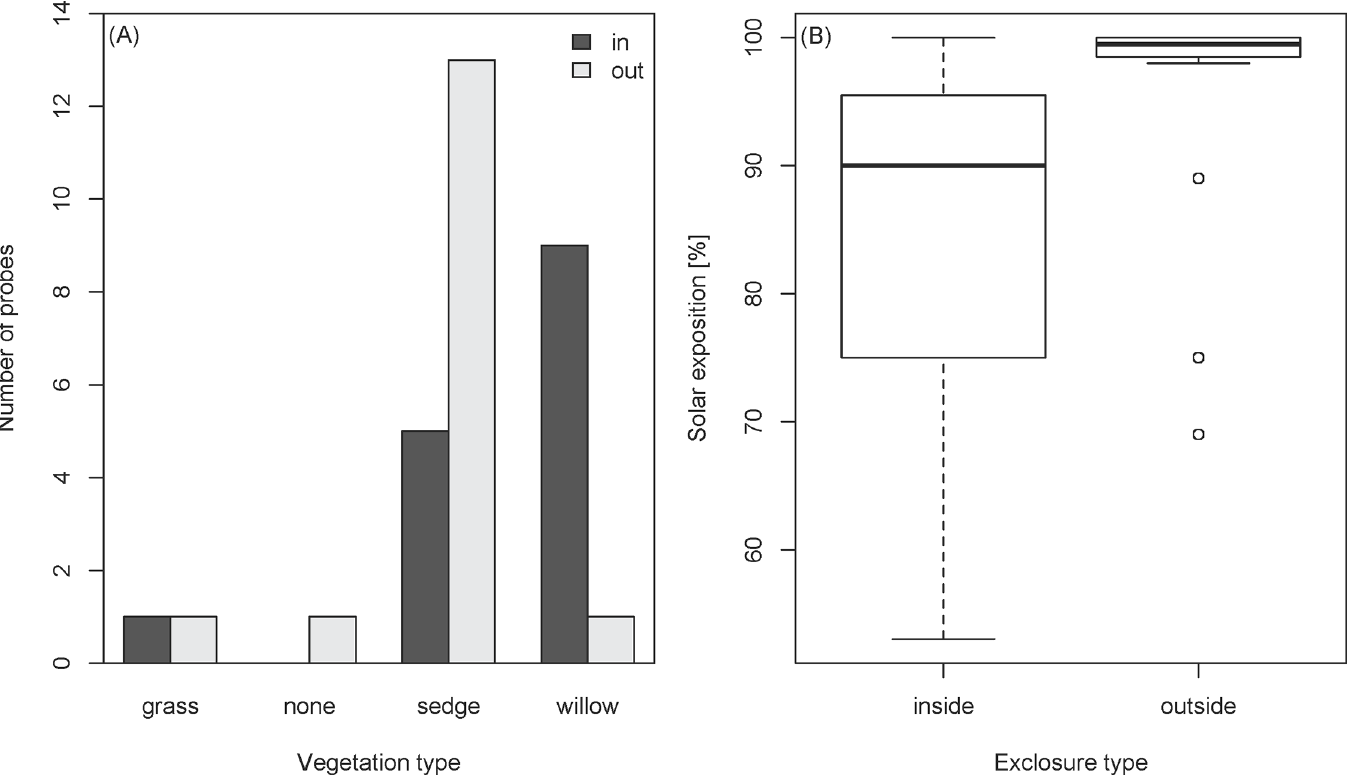
Fig 2. Environmental data in Mulkey. (A) Number of probes in Mulkey Meadows with the dominant type of vegetation indicated (grass dominated, no vegetation, sedge dominated, or willow dominated). (B) Boxplot representing the solar exposure measurements [in %], with the left boxplot representing the measurements inside the exclosure (ungrazed area) and the right boxplot representing the measurements outside the cattle exclosure (grazed area).